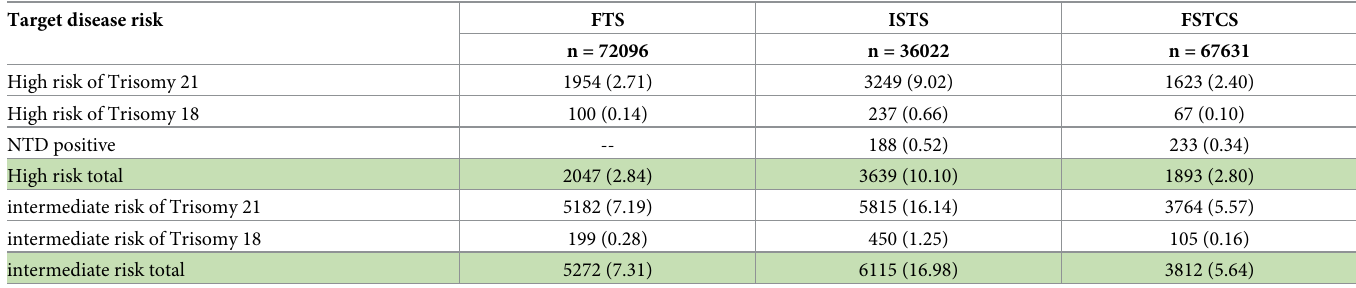
Table 2. High and intermediate risk composition ratios n (%).